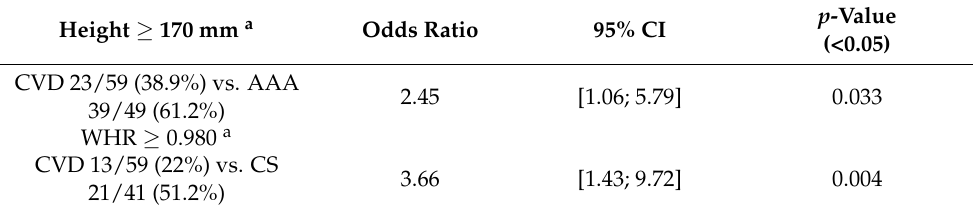
Table 3. Quantification of the association for significant Table 1. Demographics (CTRL = control group; CVD = chronic venous disease; CS = carotid stenosis; AAA = abdominal aortic aneurysm; PAD = peripheral artery disease).